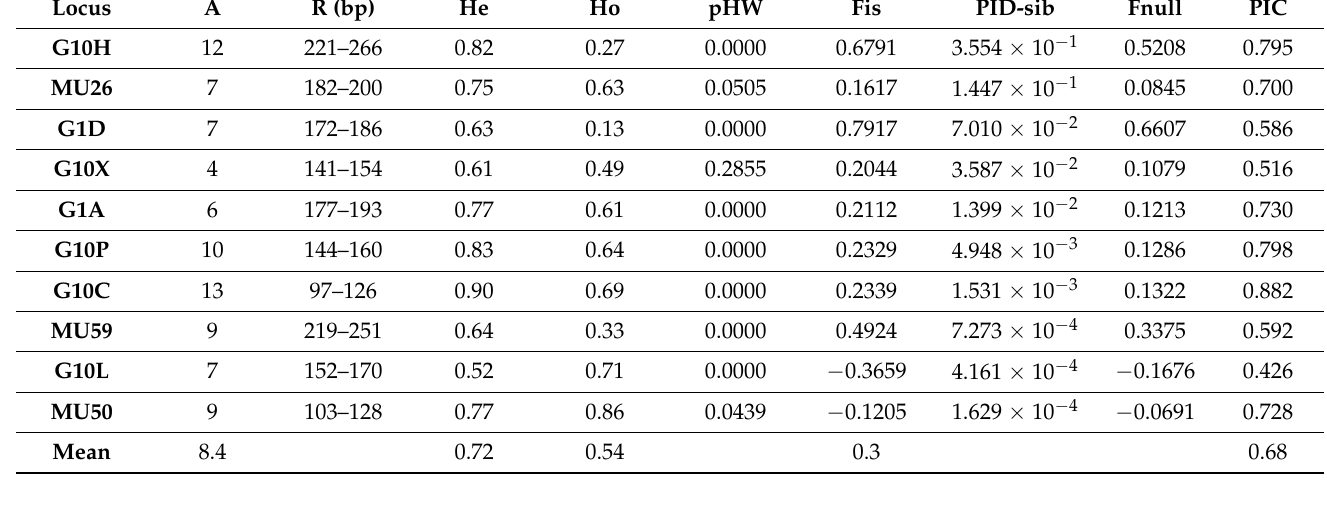
Table 7. Genetic information about the population of brown bears from Rhodopi NP. Number of alleles (A); allele size per bp (R); observed heterozygosity (Ho); expected heterozygosity (He); p -value for Hardy–Weinberg Equilibrium (pHW); inbreeding coefficient (Fis); probabilities of identity (P ID-sib ); frequency of null alleles (Fnull); polymorphic information content (PIC).